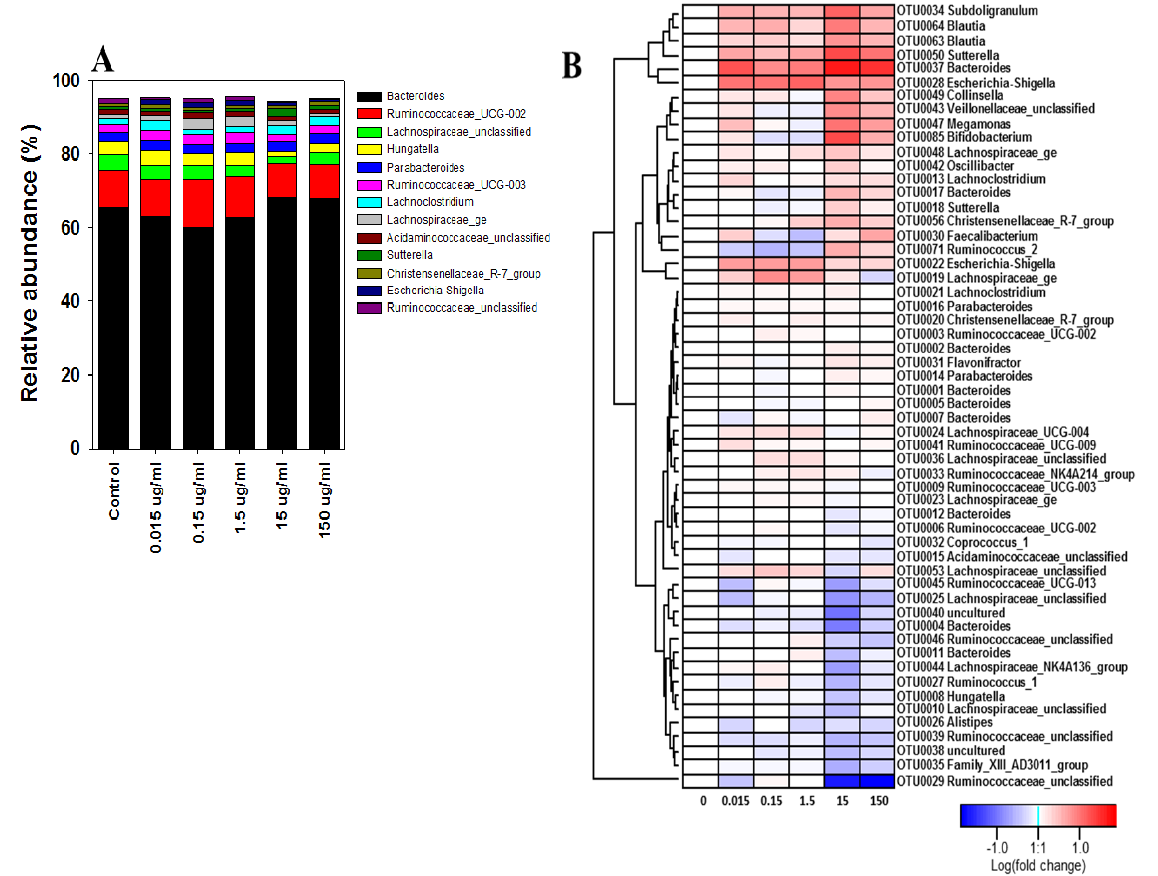
Figure 3. Bacterial communities change at the genus ( A ) and OTU levels ( B ) in controls (no treatment) and tetracycline- treated samples after 7 days. Heatmap ( B ) shows fold change of OTUs with >0.1% of relative abundance at control, and OTUs number/taxonomic group based on Mothur’s classification are represented for each row.